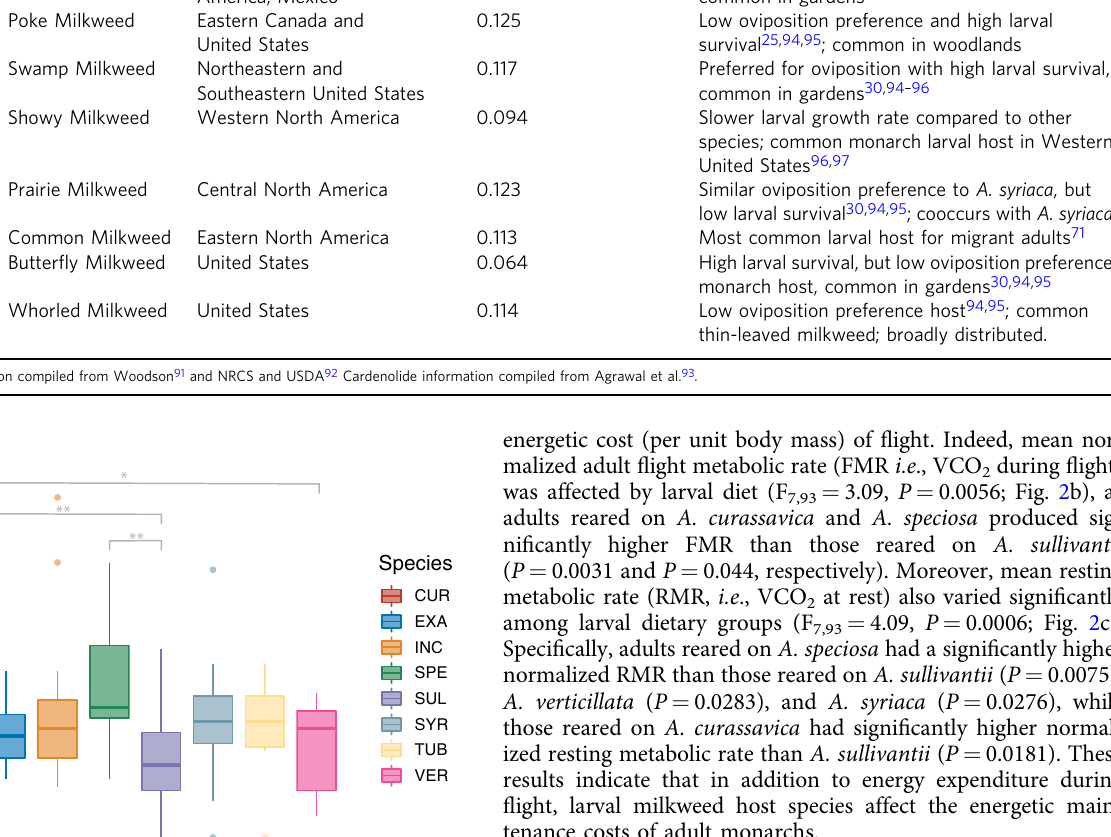
Table 1 Summary of milkweed species traits and ecological relevance. Milkweed